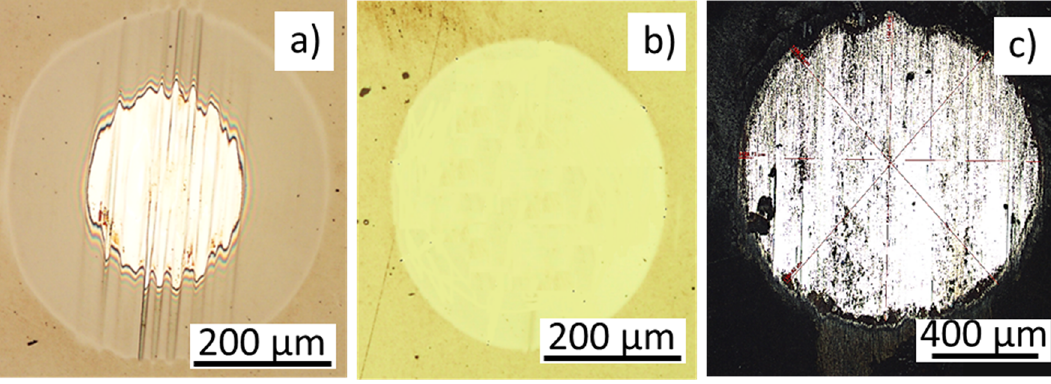
Figure 6. Wear craters formed during wear tests conducted under 2.25 N, 250 RPM, 60 minutes, a total distance of 1197 meters. a) DLC- 1: 500 µm wear crater, with exposure of the CrN intermediate layer, after removal of the DLC film; b) DLC-2: 400 µm wear crater, still showing the DLC coating; c) nitrocarburized Q&T H13 steel: 900 µm wear crater showing the exposed H13